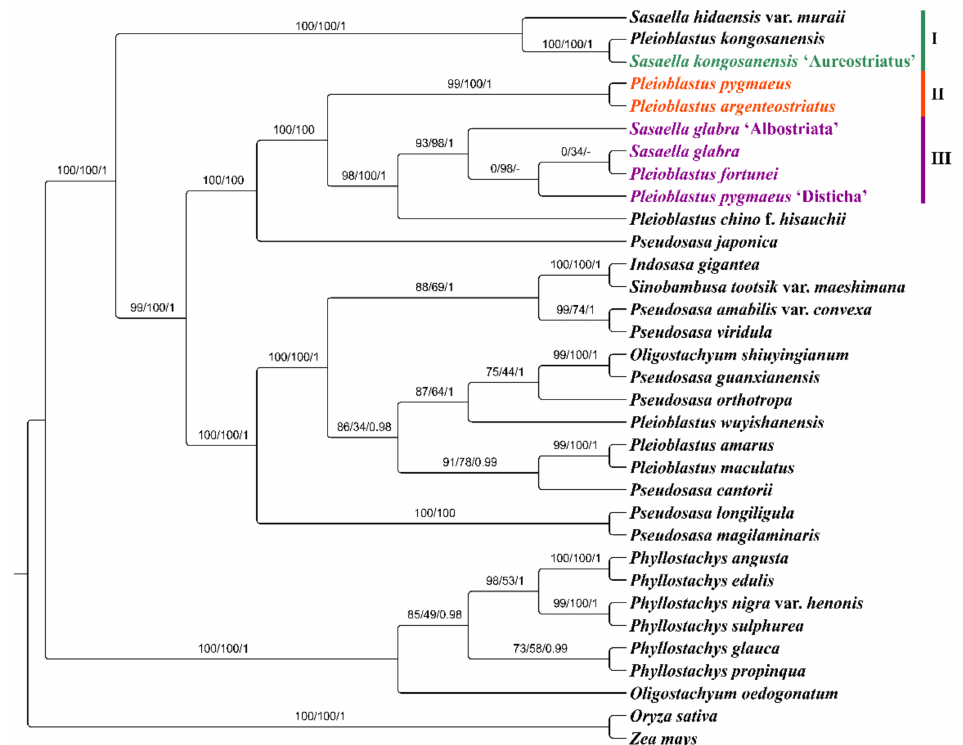
Figure 6. Phylogenetic tree of 31 Bambusoideae species and 2 others Gramineae species based on the sequences information of their full-length chloroplast genome using maximum-likelihood (ML) and Bayesian inference (BI) methods. The seven bamboo species in this study are labeled with different colors. The values for the SH-aLRT test, ML bootstrap, and BI posterior probabilities are shown by the numbers above the